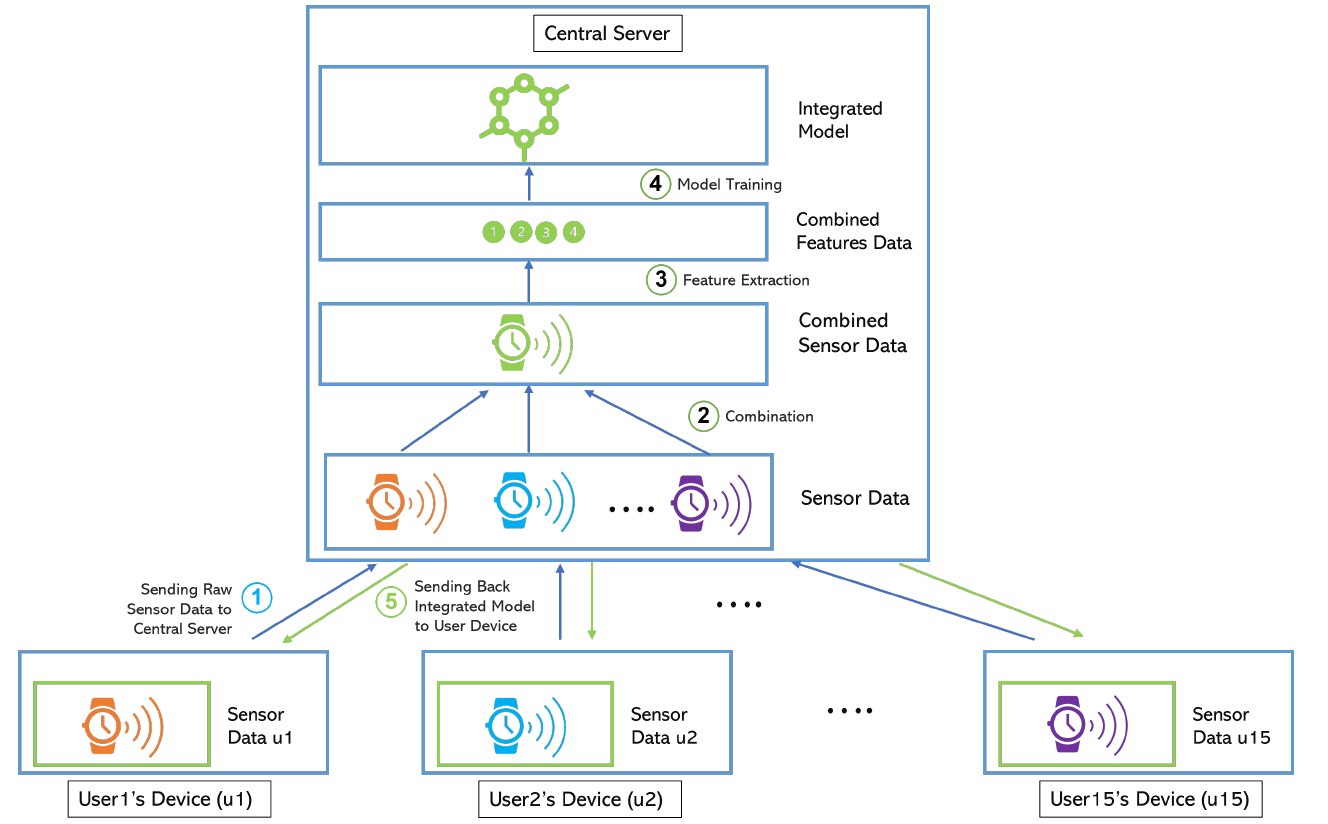
Figure 2. Centralized Learning